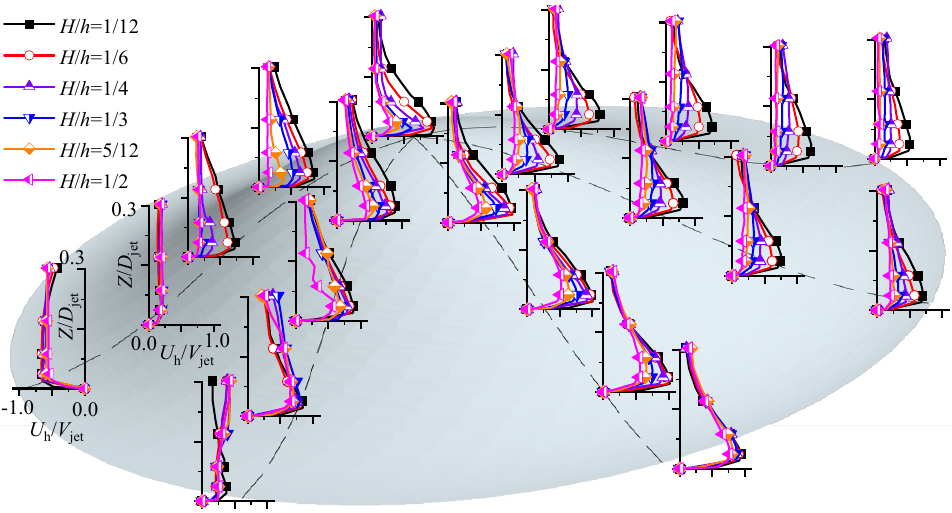
Figure 14. Profiles of horizontal wind velocity ( L = 1.0 D jet , r h = 0.8 D jet ).